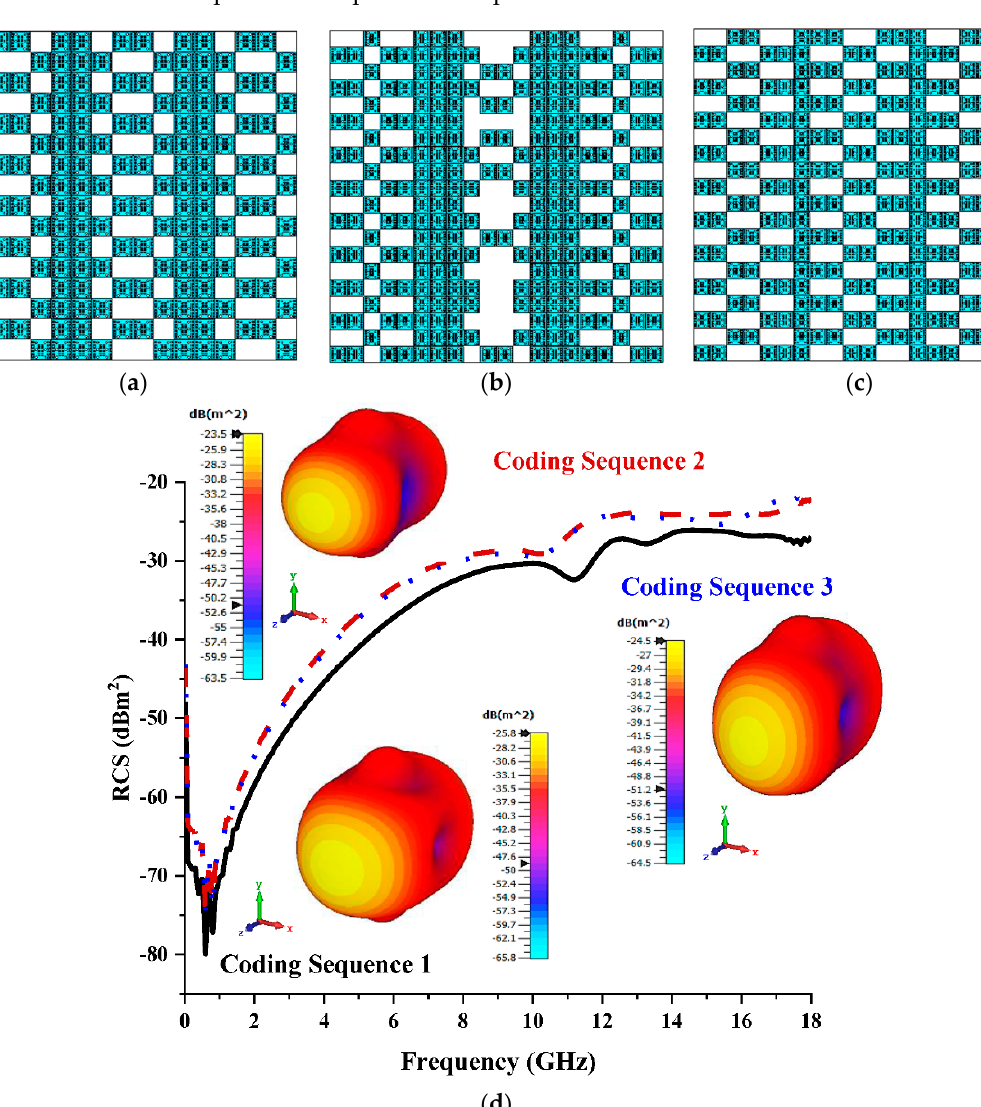
Figure 6. Twenty lattices: ( a ) Coding Sequence 1; ( b ) Coding Sequence 2; ( c ) Coding Sequence 3; ( d ) monostatic RCS and bistatic scattering pattern at 15 GHz.